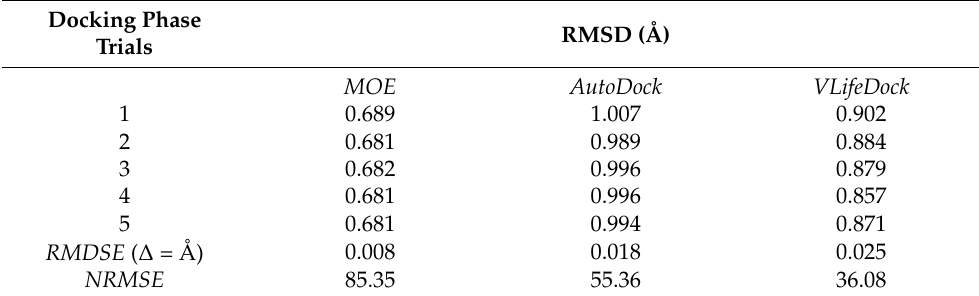
* Lower values for RMSE indicate higher precision. Lower values for RMSD indicate higher accuracy. RMSDE: Root-mean-square deviation error = RMSD (maximum value) − RMSD (minimum value), and a lower RMSDE value indicates more reproducibility. Reproducibility was measured in terms of normalized root-mean-square deviation or error (NRMSD or NRMSE: this is a fraction number which measures the degree of reproducibility) [46–48]. NRMSE = (average RMSD attained/RMSDE). NRMSE value for any provided method tells the frequency of the accuracy of getting docking conformation, and higher values indicate better